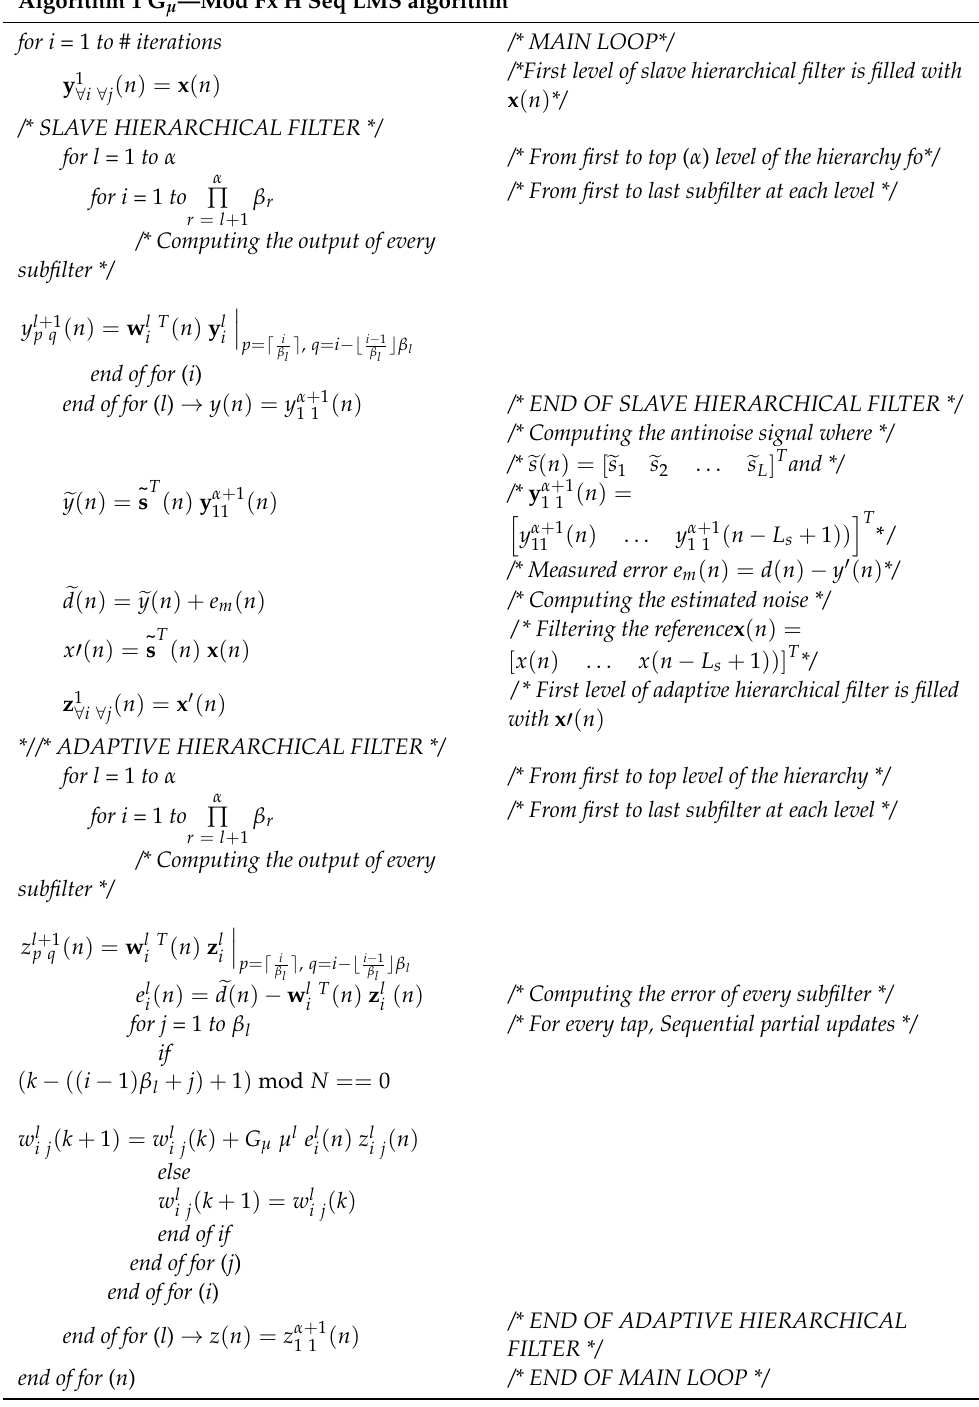
Algorithm 1 G µ —Mod Fx H Seq LMS